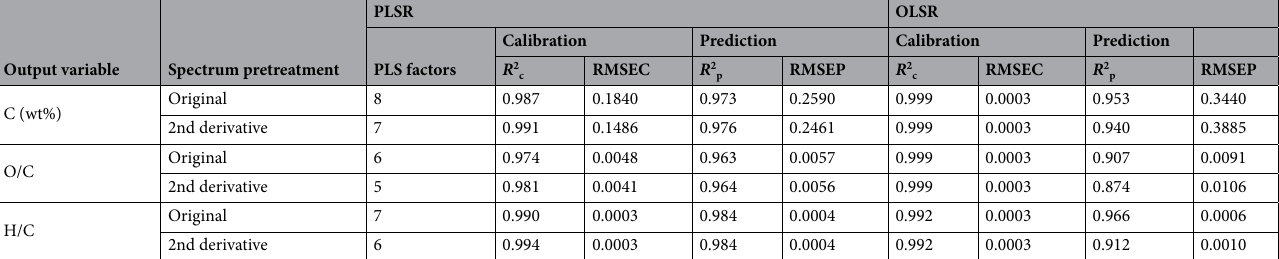
Table 2. Prediction performance for carbonization characteristics of PLSR models in NIR spectra with 1250– 2300 nm region and comparison with OLSR models. PLSR partial least squares regression, OLSR ordinary least squares regression, R 2 c coefficient of determination for calibration, R 2 p coefficient of determination for prediction, RMSEC root mean square error of calibration, RMSEP root mean square error of